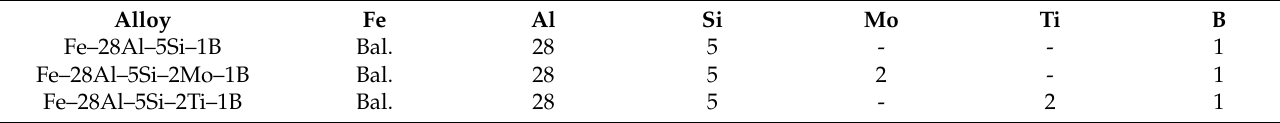
Table 1. The nominal chemical composition of investigated alloys [at.